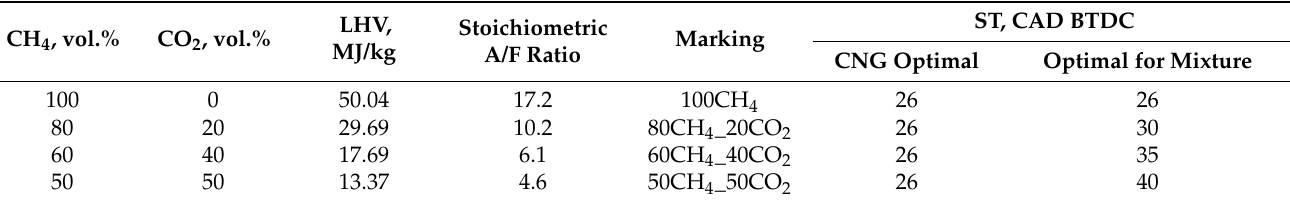
Table 3. Simulated biogas properties and ST cases.